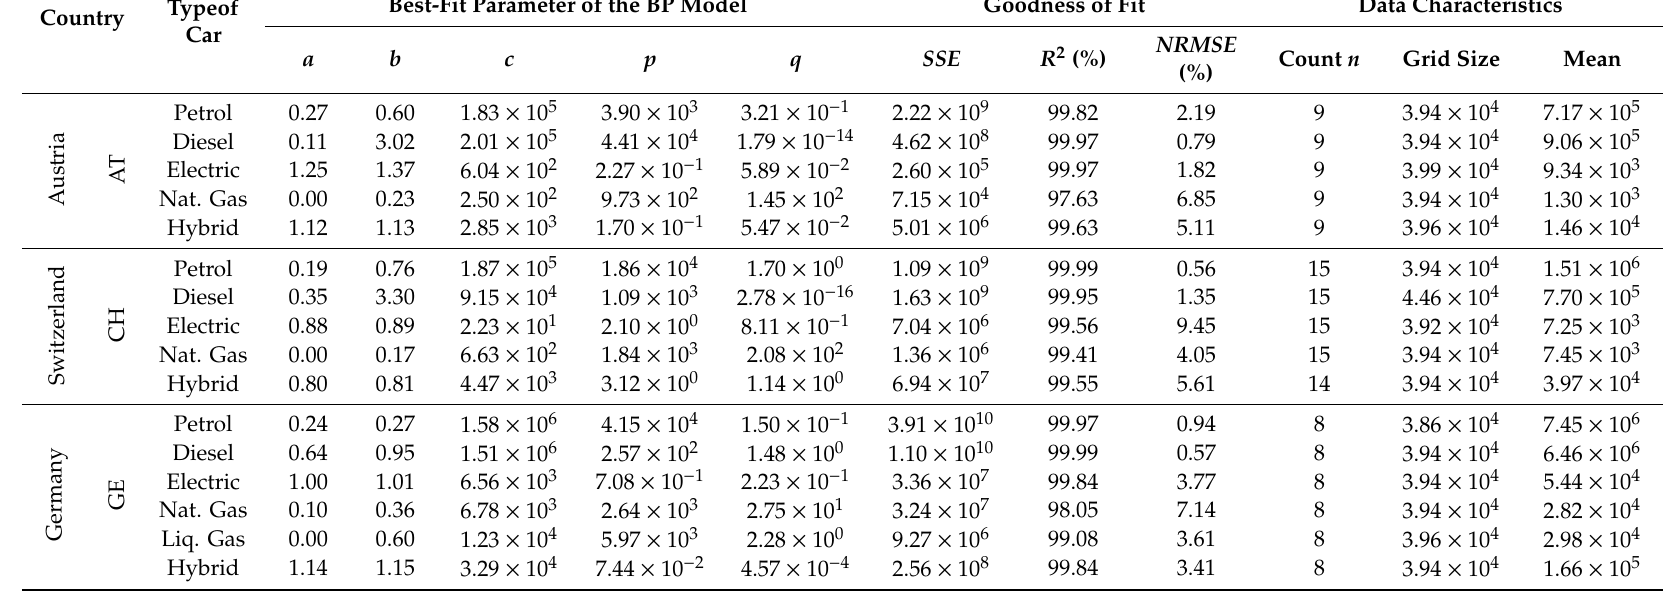
Table 2. Parameters for Equation (1) with best fit to the stock of cars (computed from Table 1).